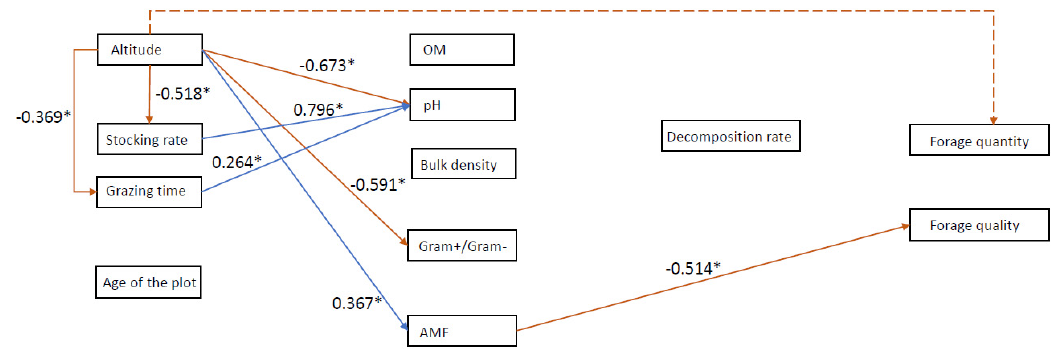
Figure 3. Conceptual model showing significant relations among variables after multivariate analysis, suggesting that livestock management practices may have an effect on ecosystem services either in a direct or in an indirect way. Significant standardized β coefficients from multiple regressions are shown next to each path (*). Blue arrows indicate positive relations, red arrows negative relations ( p ≤ 0.05). The dotted line indicates a marginally significant relation (0.05 ≤ p ≤ 0.10). OM: soil organic matter; AMF: arbuscular mycorrhizal fungi.